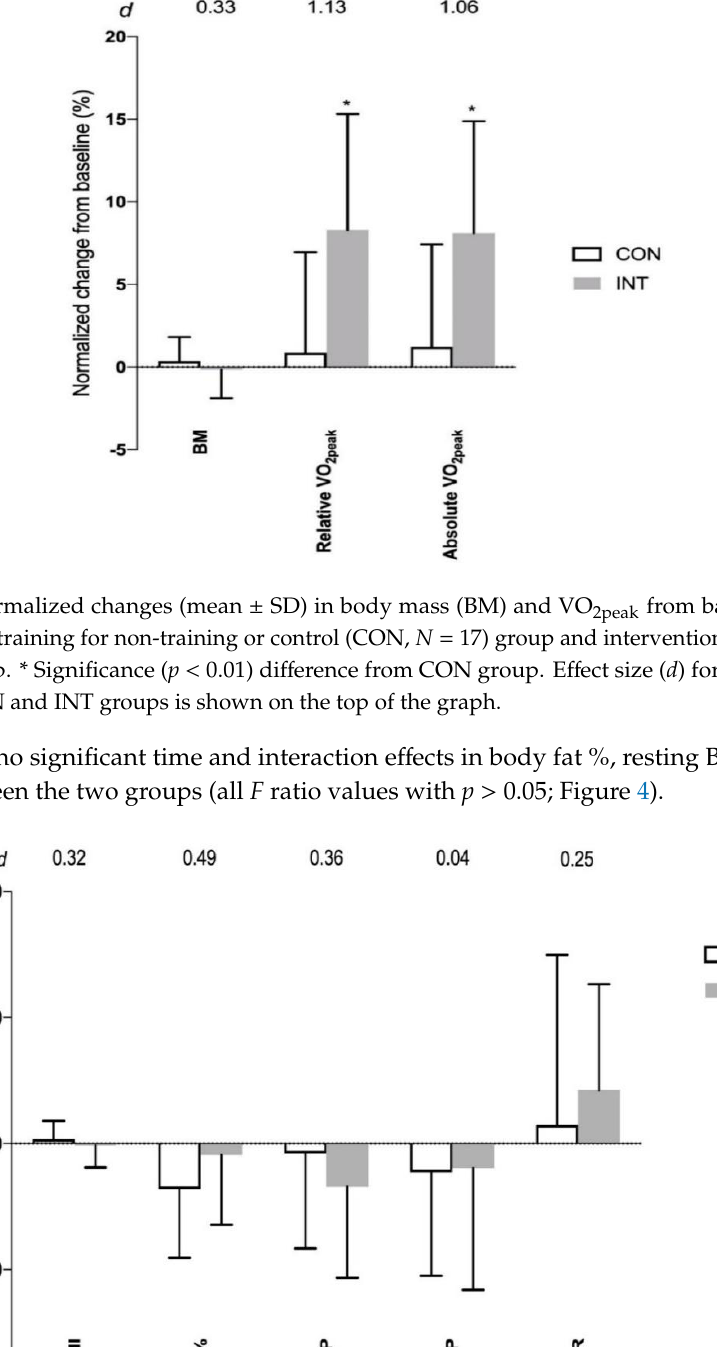
◦ · − 1 s for flexion and